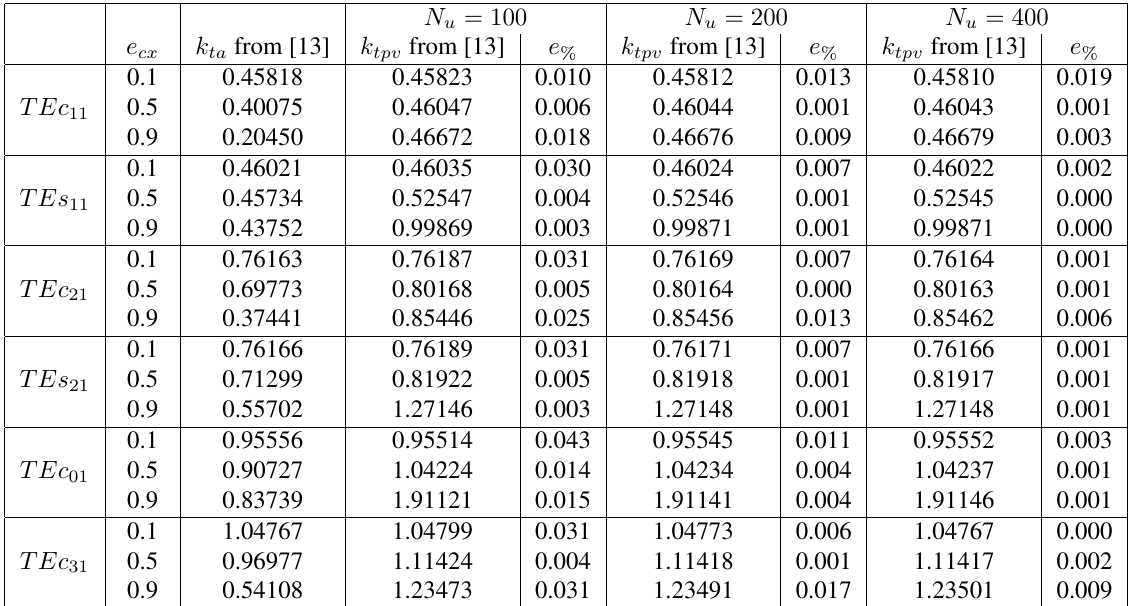
Table 3: Validation test for an elliptic